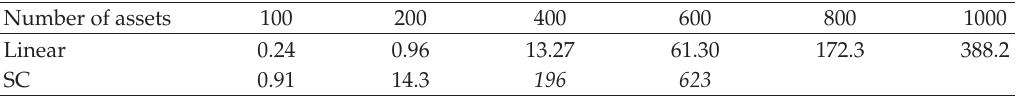
Table 2: CPU-times (cid:6) in seconds per point (cid:7) of the EC1 stage of the ε -constraint method in the linear and semicontinuous case as a function of the number of assets. The results are mean values obtained by calculating ten 20-point samples corresponding to ten di ff erent sets of (cid:6) real (cid:7) data, except for the numbers in italics, which have been obtained by solving a single instance of a single problem (cid:6) computations have been made with GAMS (cid:7)